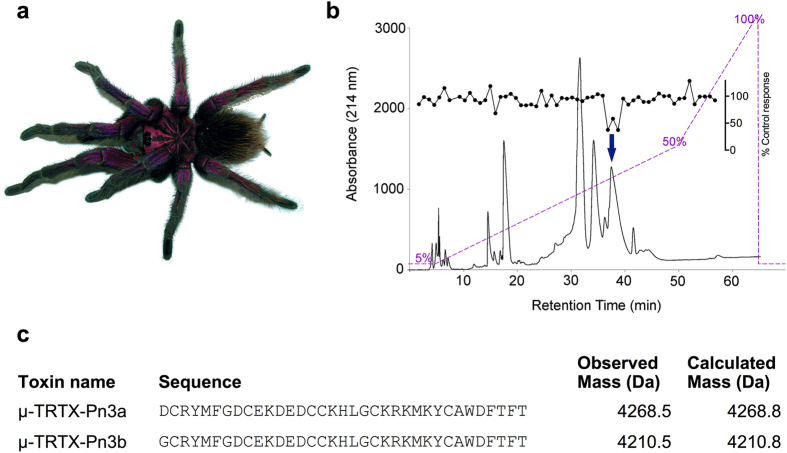
Isolation of the novel spider peptide μ-TRTX-Pn3a from the venom of Pamphobeteus nigricolor.(a) Photo of the male Pamphobeteus nigricolor specimen from which crude venom was obtained. (b) Chromatogram resulting from fractionation of the crude venom using RP-HPLC (purple dashed line indicates acetonitrile gradient). Corresponding activity of each fraction to inhibit veratridine-induced NaV1.3 responses is shown above (black circles). The arrow indicates the active peak. (c) Sequences of μ-TRTX-Pn3a and μ-TRTX-Pn3b identified by N-terminal sequencing.